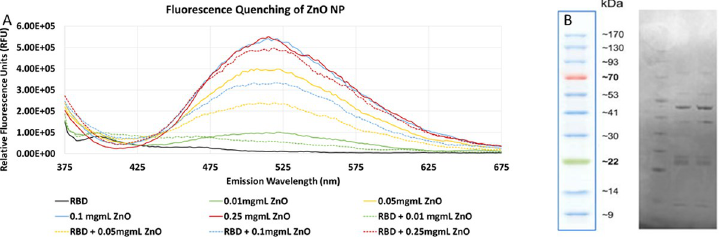
Fig 2. A. Fluorescence quenching of ZnO NP in the presence and absence of RBD measured at 350 nm further confirming interaction. B. SDS-PAGE analysis of RBD and ZnO nanoparticle combination: Lane 1 –Protein Ladder Lane 2 –RBD alone Lane 3 –RBD and ZnO NP